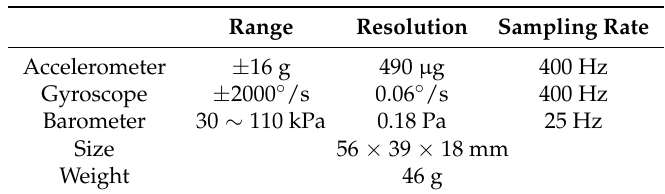
Table 1. NGIMU specifications.